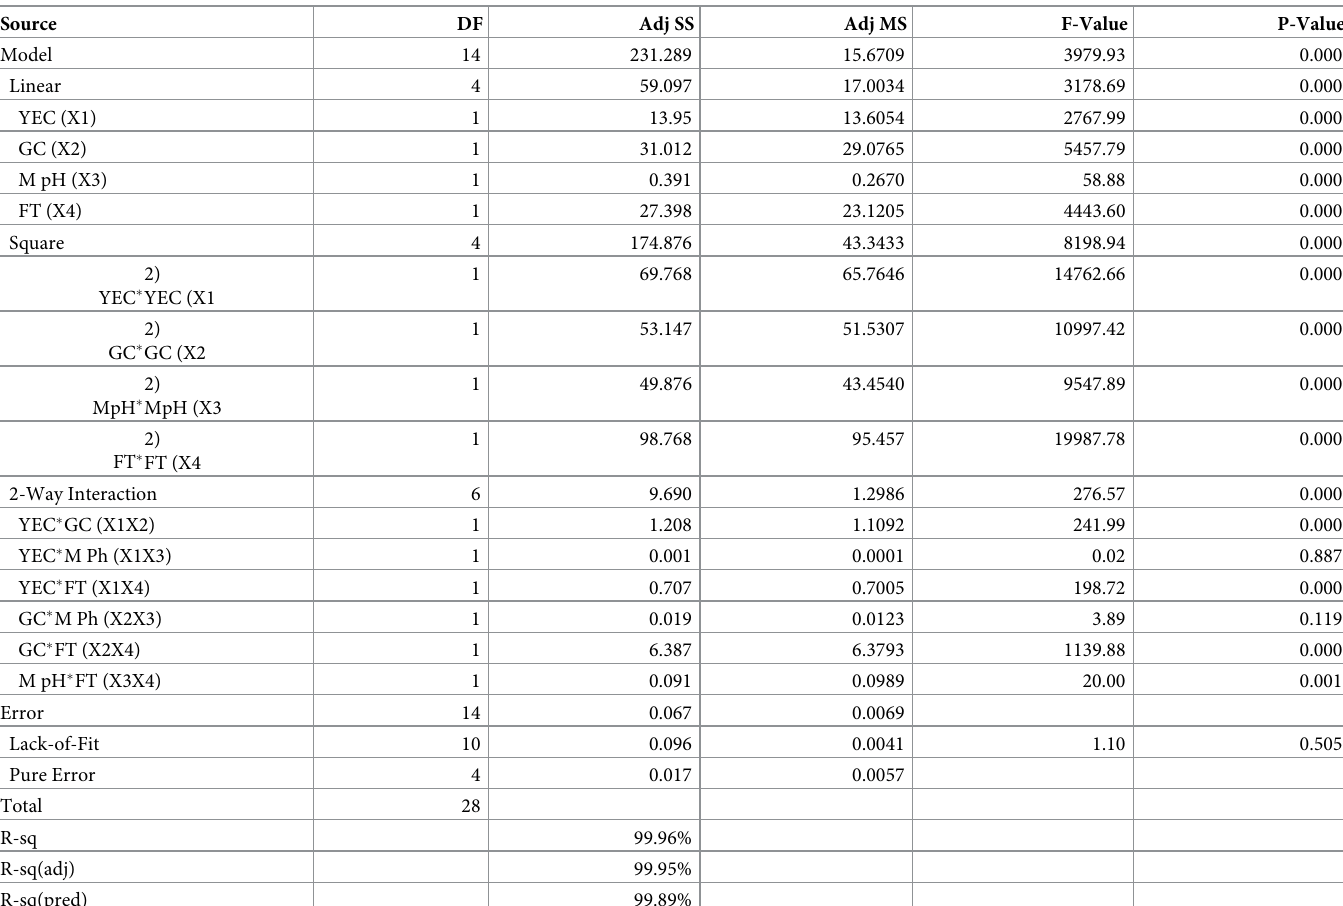
Table 5. ANOVA for response surface quadratic regression model of antibacterial productions by endophytic Colletotrichum alatae LCS1. Source